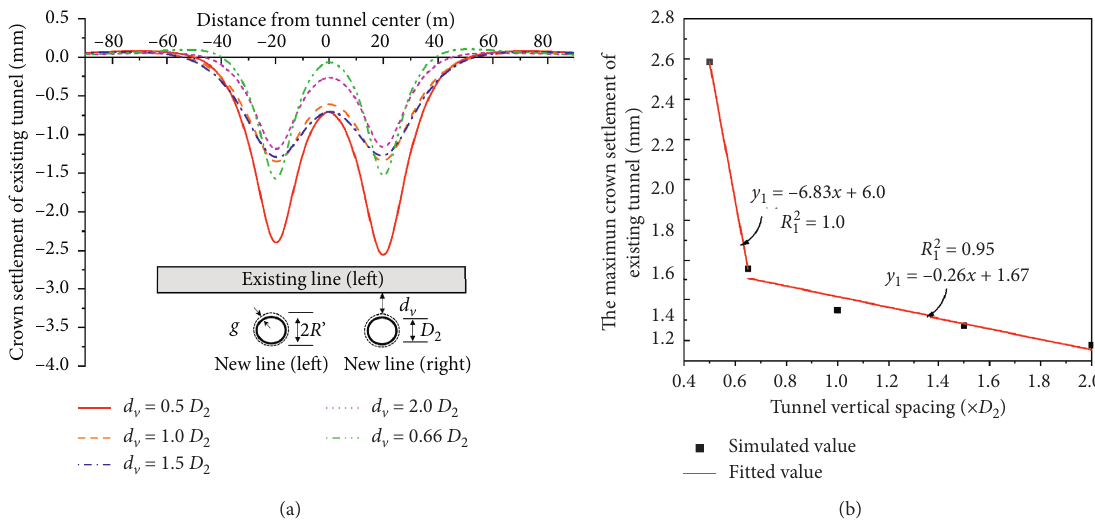
Figure 14: The crown settlement curves of existing tunnel with the vertical spacing variation. (a) The settlement curves of the existing tunnel. (b) The linear fitting of the maximum settlement value of the existing